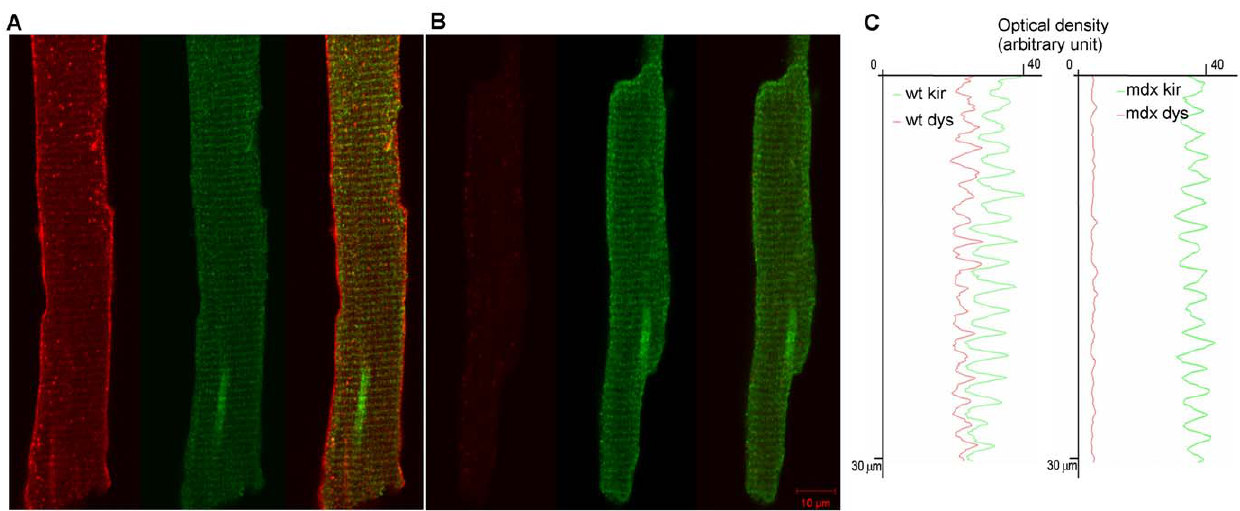
Figure 5. Kir6.2 retains the t-tubule subcellular localization in the absence of dystrophin. Immuno-fluorescence analysis of young adult wt and mdx mutant cardiomyocytes stained for Dys427 and Kir6.2 (A, B). Note dystrophin (red) presence at the plasma membrane and t-tubules of the wt fiber (A, left image) while it is not detectable in the mdx mutant fiber (B, left image). Kir6.2 (green, A and B center images) is associated to the t- tubules in both wt and mdx mutant fibers. A and B, right images, show co-staining of Dys427 and Kir6.2. Longitudinal optical density profiles (C) plotted in red for dystrophin and in green for Kir6.2 show identical spacing in wt cardiomyocytes suggesting co-localization of the two proteins. Note that the profile for Kir6.2 in the mdx mutant fiber is indistinguishable from that of the wt fiber.